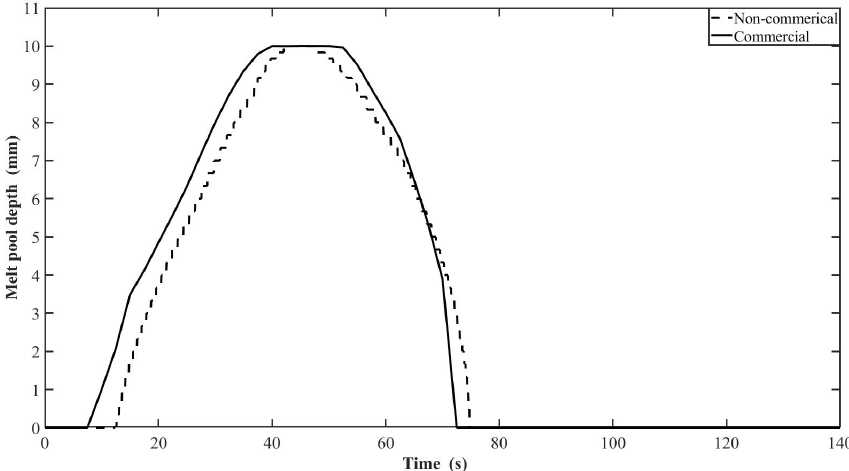
Figure 10. Comparison of melt pool depth obtained by non-commercial and commercial model along the length of the cylindrical rod.